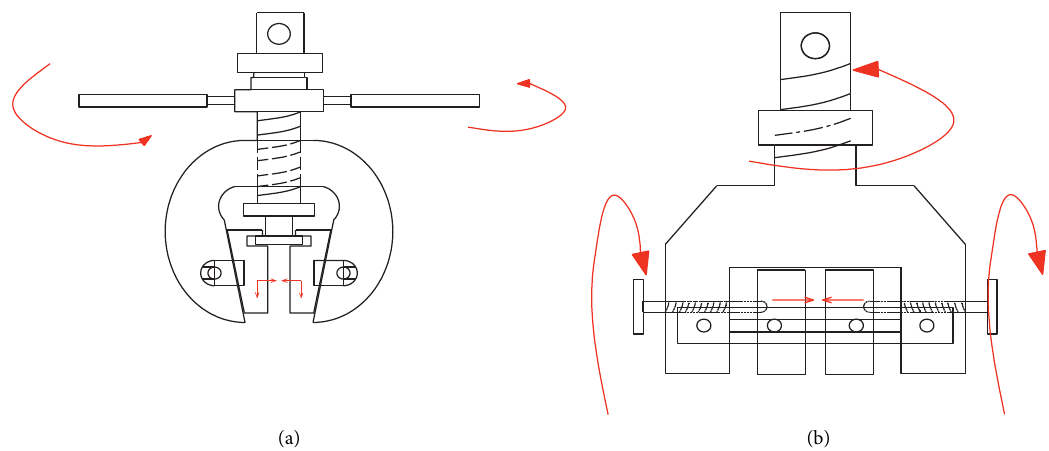
Figure 2: The schematic diagram of direct drawing fixture. (a) The original fixture. (b) Improved fixture.